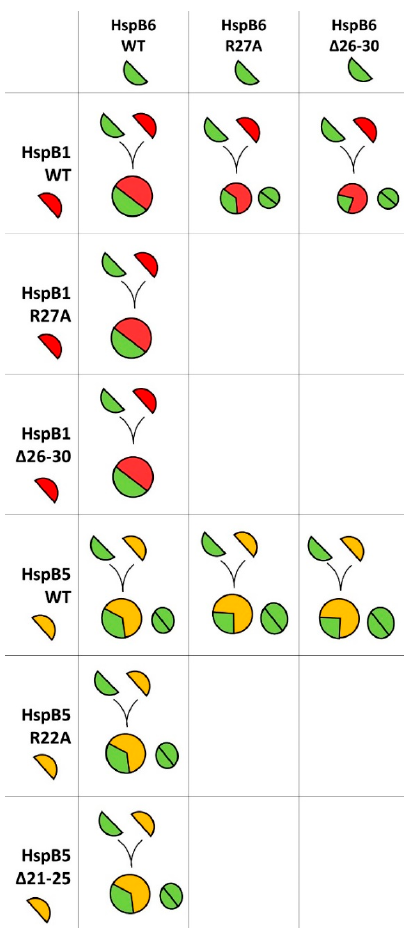
Figure 9. Hypothetical scheme of heterooligomerization of HspB1, HspB5 and HspB6 and their N-terminal mutants. HspB1, HspB5 and HspB6 monomers are represented as red, yellow and green half circles, respectively. Full circles represent homo- or heterooligomers and the colored area corresponds to the portion of the corresponding protein in heterooligomer. The interaction of HspB1 and HspB6. The WT HspB1 and HspB6 form heterooligomeric complexes containing similar 1:1 ratio of two proteins. Mutations of HspB1 NTD weakly affect its interaction with HspB6. Mutations of HspB6 compromise its interaction with the WT HspB1 and significant portion of HspB6 was not included in heterooligomers. The interaction of HspB5 and HspB6. The WT HspB5 and HspB6 form definite heterooligomeric complex with stoichiometry HspB5 / HspB6 close to 2:1. Mutations of HspB5 NTD weakly affect interaction with HspB6 and